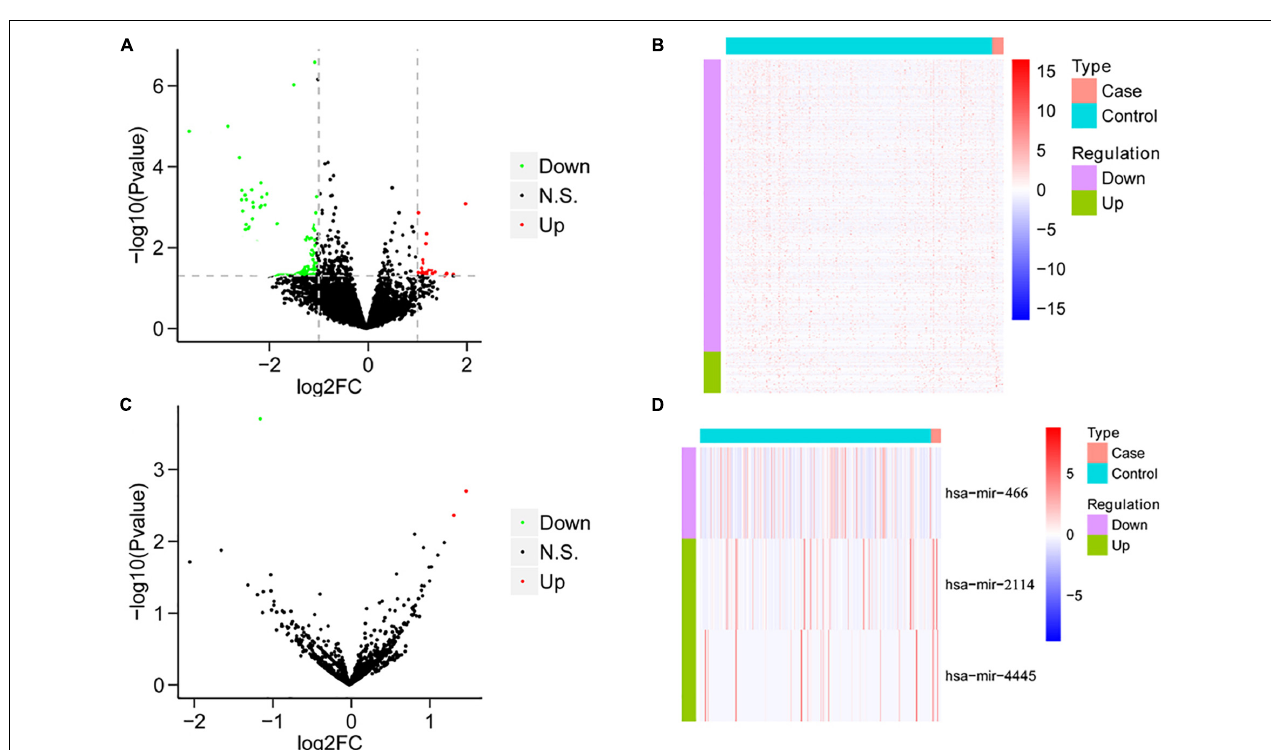
FIGURE 1 | The results of differential analysis of mRNA and miRNA. (A) Volcano diagram of differentially expressed mRNA. The horizontal axis is the Log2FC value, and the vertical axis is –log10 ( P -value). The red color represents upregulation, green represents downregulation, and black represents no significant difference. (B) Heat map of differentially expressed mRNA. Behavioral genes are listed as samples. Red represents high expression, and blue represents low expression. (C) Volcano map of differentially expressed miRNA. (D) The heat map of differentially expressed miRNA expression.